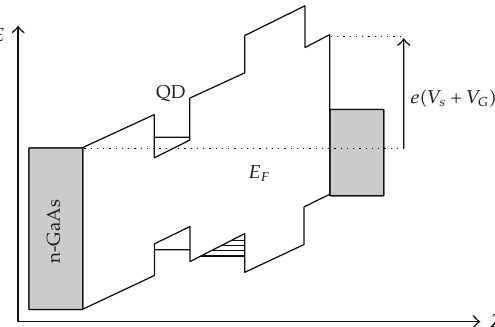
Figure 4: Schematic sketch of the heterostructure (cid:5) under reverse bias (cid:6) displaying the conduction and valence band edges energy along the growth direction. The applied gate voltage V G is superimposed on the Schottky voltage V S of the order of − 1 . 5V for our